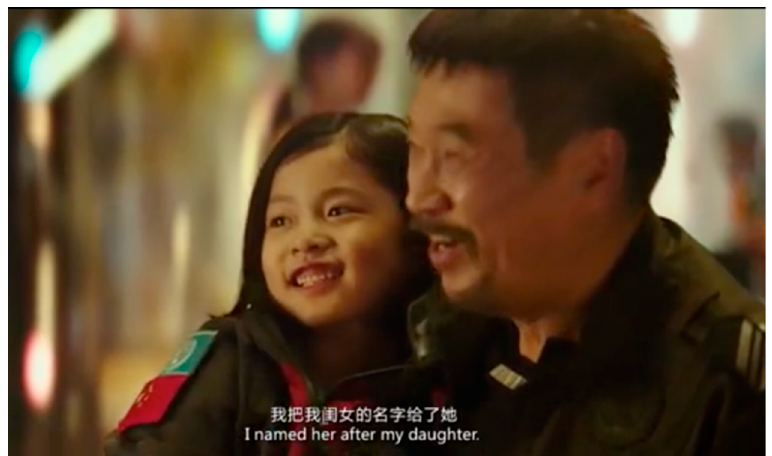
Figure 3. Han Zi’ang names the orphan girl after his deceased daughter Han Duoduo.